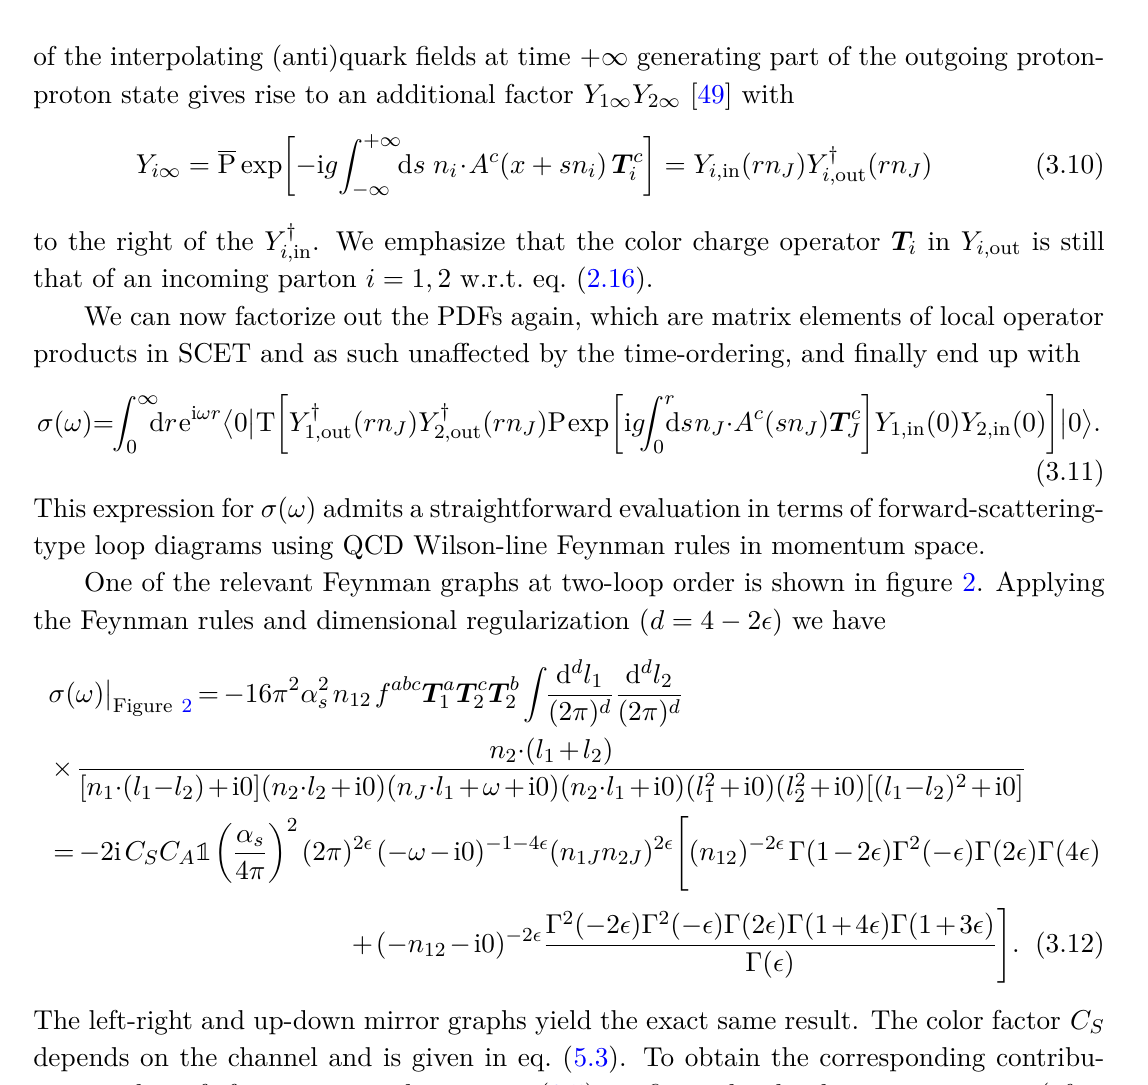
Figure 2. Two-loop diagram contributing to σ ( ω ) and responsible for the imaginary part of Disc ω σ ( ω ) at this order. The external double lines on the left (right) correspond to the semi-infinite lightlike Wilson lines Y ( † ) , the middle double line corresponds to the finite-length Wilson line i, in(out) in eq. (3.11). The little arrows indicate the parton flow for a generic parton channel with color charge operators T c for each Wilson line vertex. The crossed vertices on the left (right) indicate i the (complex conjugated) hard